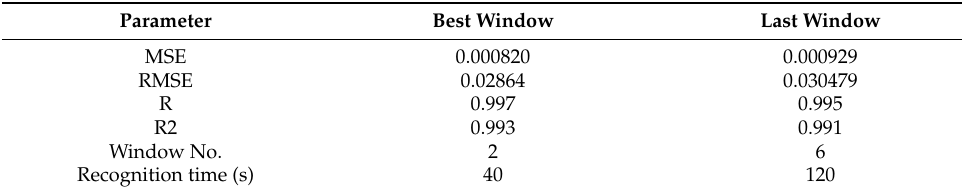
Table 6. Summary of performance of SVM-R algorithm.